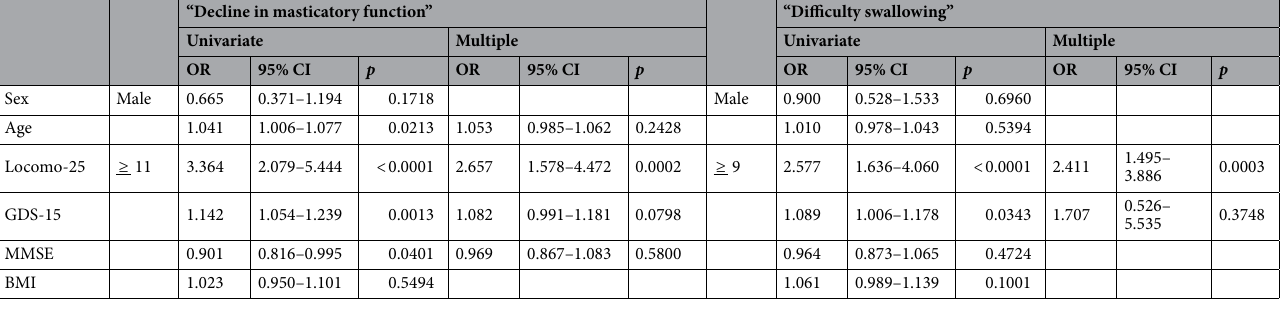
Table 4. Odds ratios of variables for “decline in masticatory function” and “difficulty swallowing” according to the Locomo-25 score. Univariate and multiple logistic regression analyses were performed. OR odds ratio; CI confidence interval; GDS-15 Geriatric Depression Scale; MMSE Mini-Mental State Examination; BMI body mass